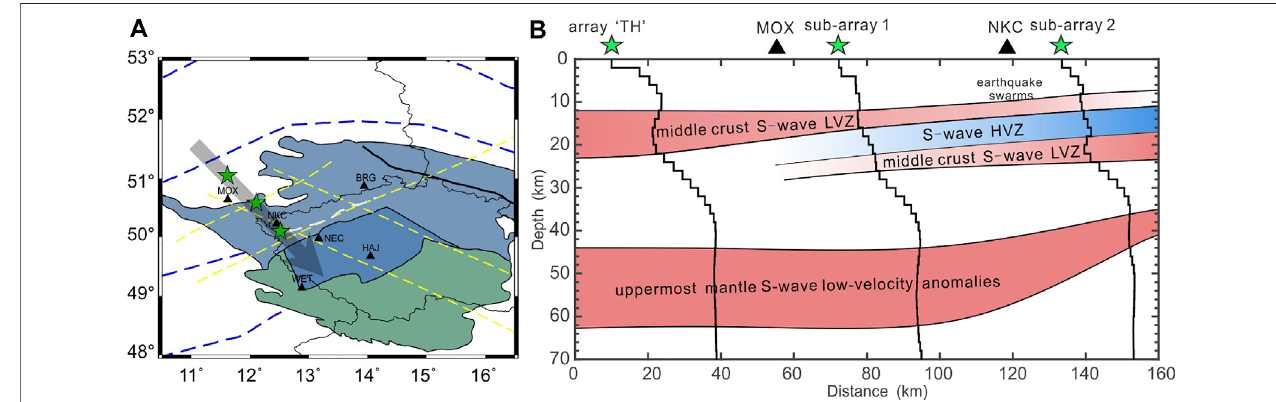
FIGURE14| Locationofthepro fi leandlow-velocitydistribution (A) Thethreegreenpentagramsarethecenterpositionsofarray “ TH ” ,subarray1,andsubarray2. (B) A simple schematic diagram depicting the distribution of the S-wave LVZs in the middle crust and the S-wave low-velocity anomalies in the uppermost mantle along the pro fi le. The earthquake swarms beneath the station NKC occur at depths of 6 – 11